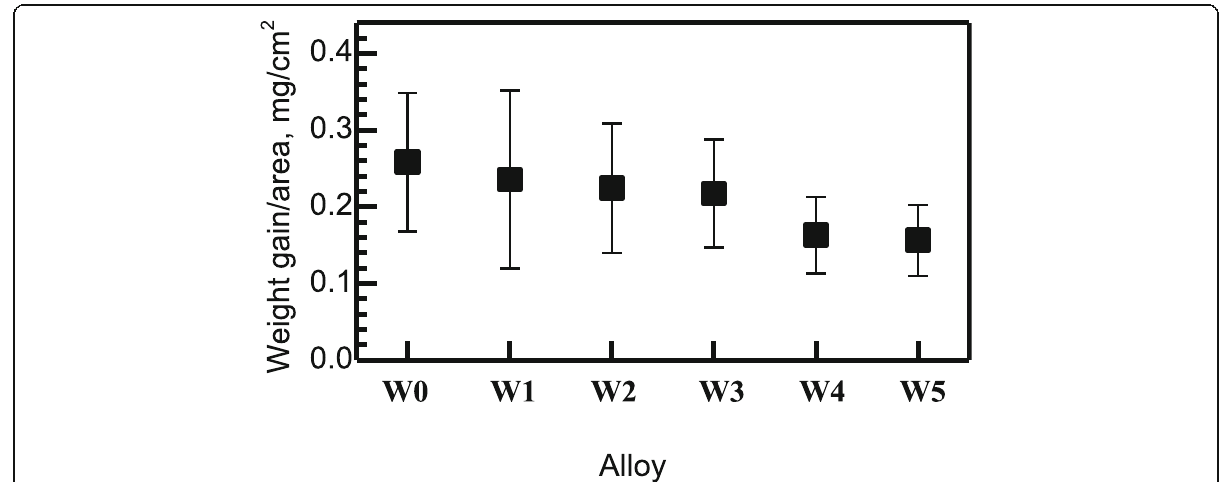
Fig. 1 Weight gain of the alloys after 336 h of oxidation at 1053 K (error bars represent standard deviations)